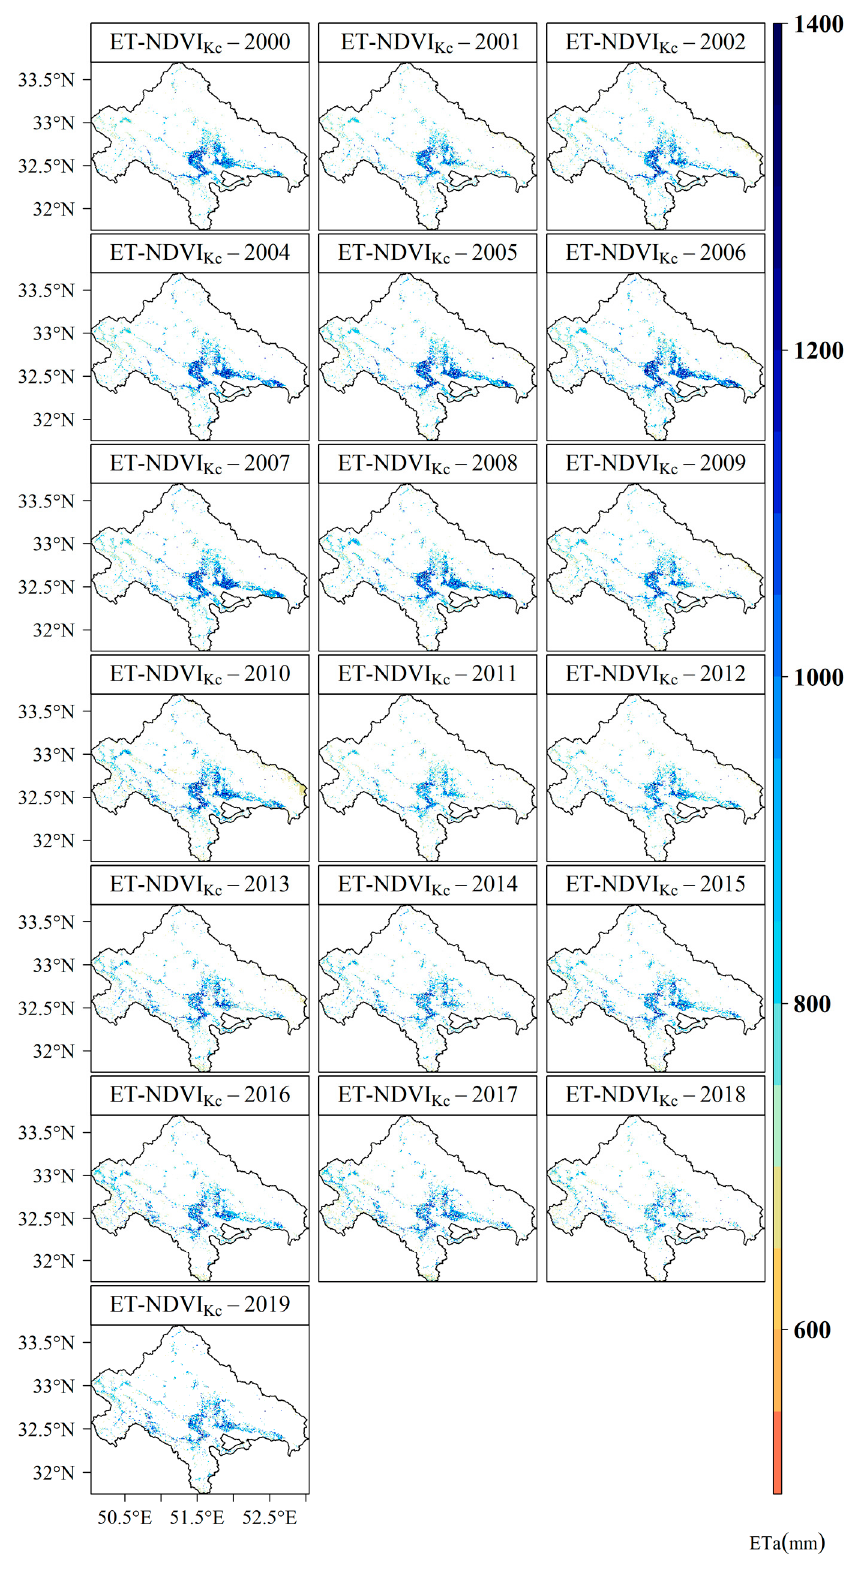
Figure A4. Annual maps of ET-NDVI Kc .